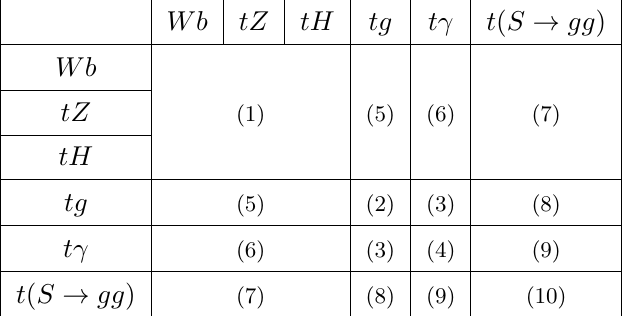
Table 5 . Possible (cid:12)nal states from the pair-produced top